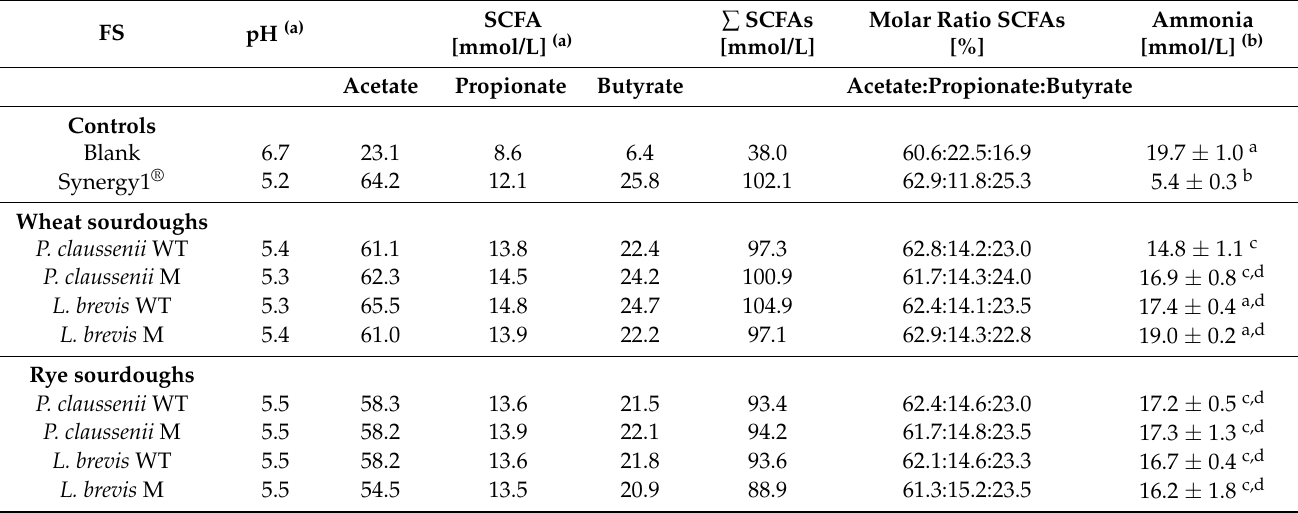
Table 3. pH values, SCFA concentrations, molar ratios of main SCFAs and ammonia concentrations in FS of